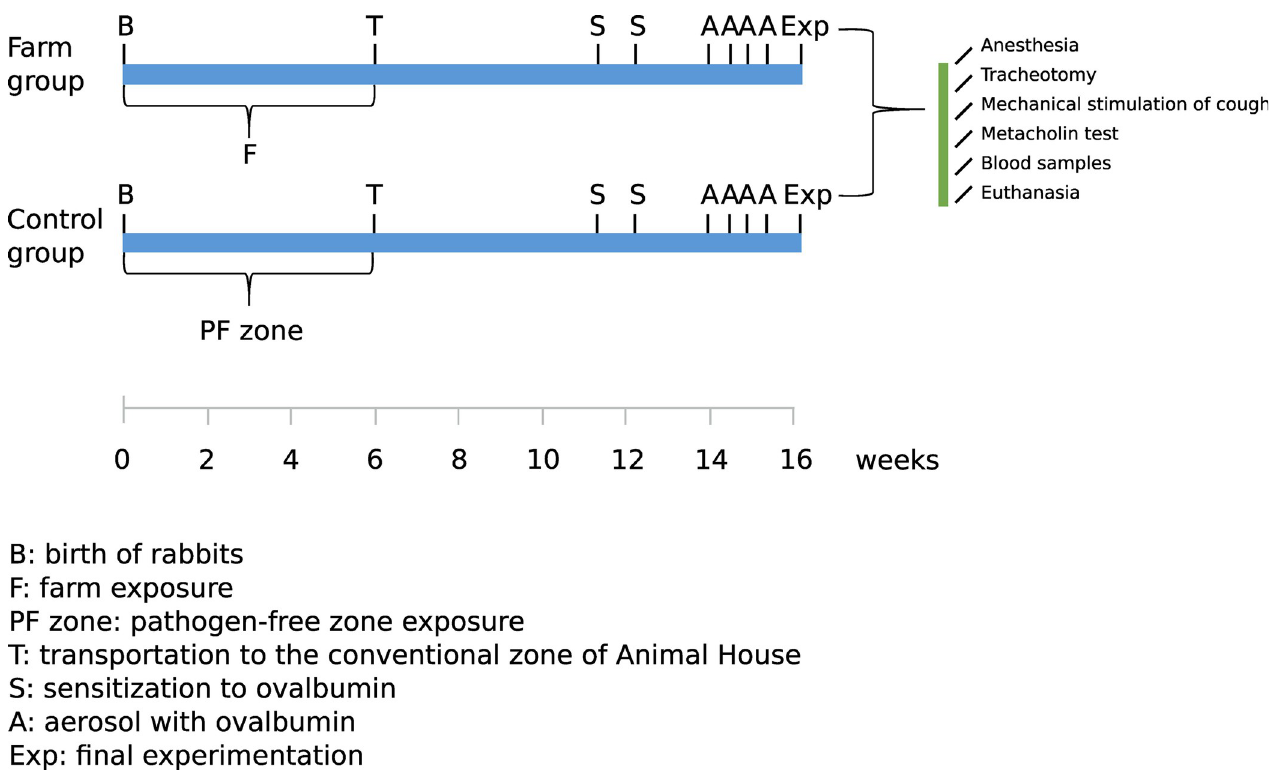
Fig 1. Sensitization and challenge